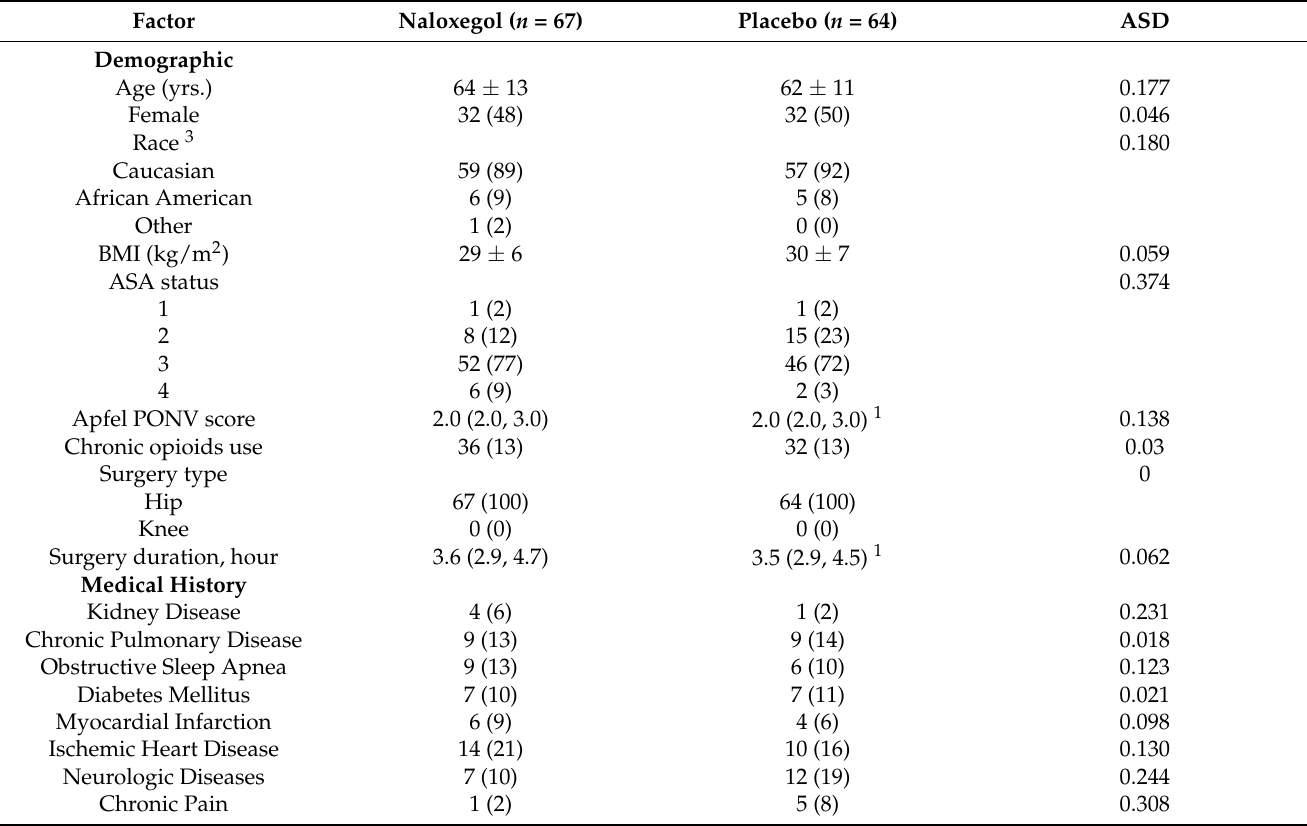
Figure 1. Flowchart of screening, randomization and withdrawal of patients. Table 1. Baseline characteristics by group.